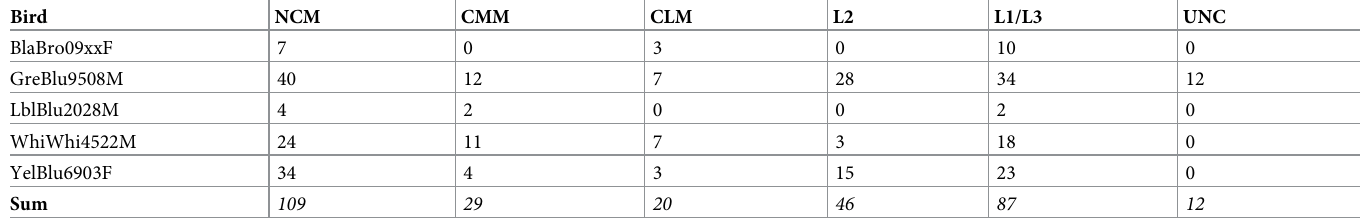
Table 1. Number of units per bird and per anatomical area that was included in our anatomical analyses (n = 303). The UNC column counts the units that we left as unclassified because they were found at the boundary between